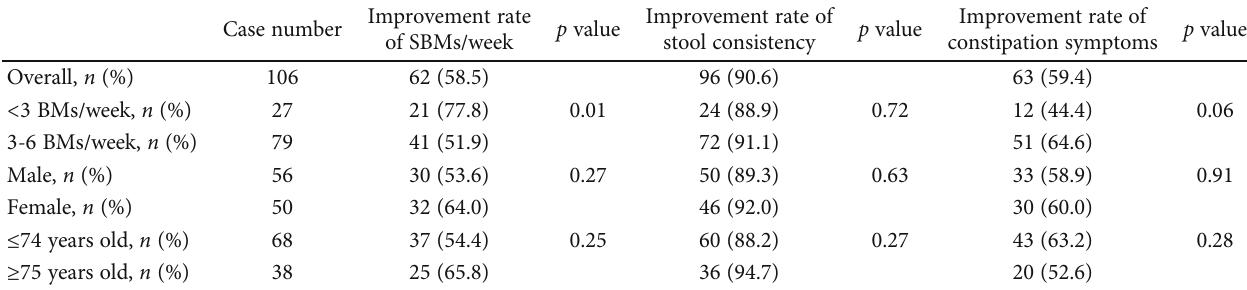
Table 3: Improvement of SBMs, stool consistency, and constipation symptoms in number of BMs/week, gender, and age.